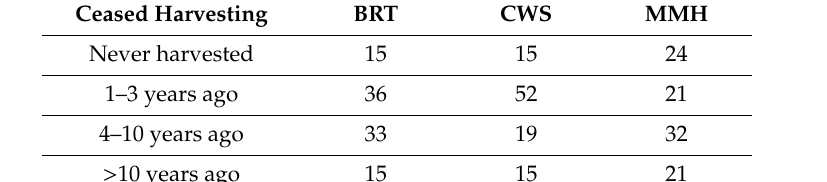
Table 4. Proportion (%) of non-harvesters who had previously harvested and time since cessation.